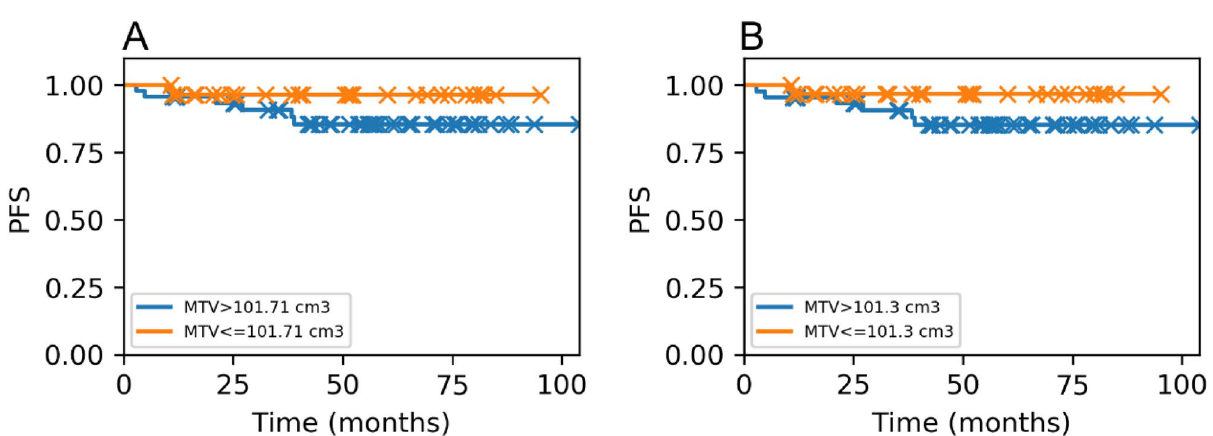
Figure 7. Kaplan–Meier analysis showing the predicted patient outcomes according to the TMTV cut-offs found in ROC for a SUV 2.5 threshold in ( A ) BI and in ( B )